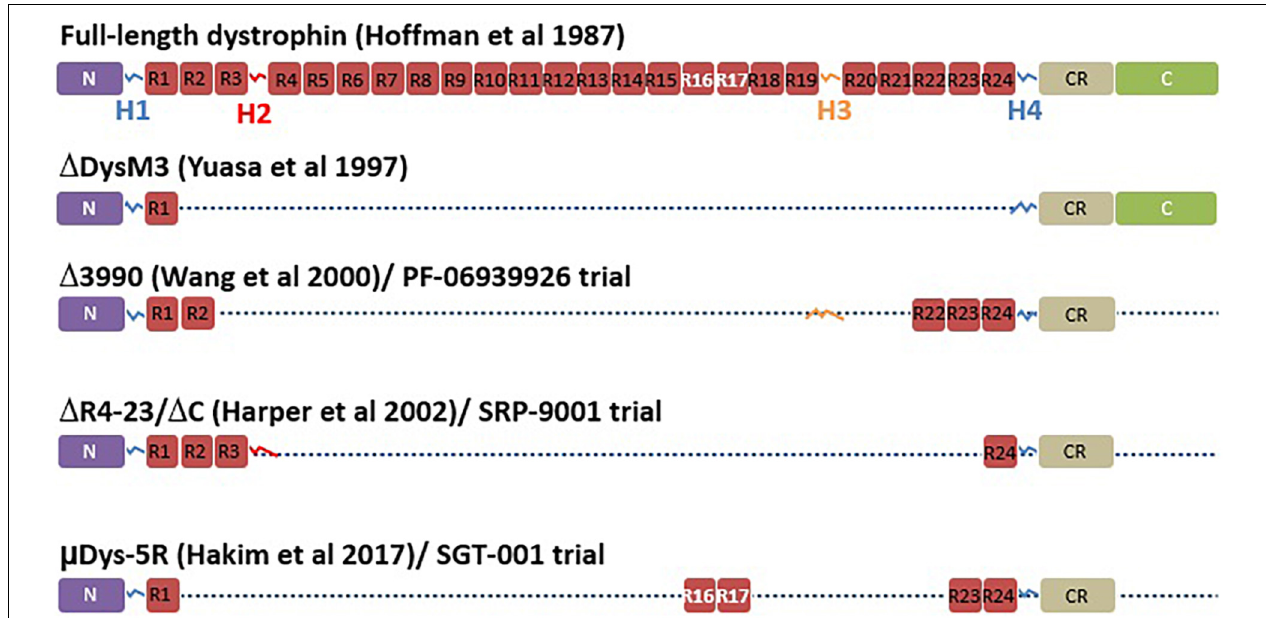
FIGURE 4 | Micro-dystrophin variants. This figure adapted from Duan et al. (147) represents the full-length dystrophin with different domains including the N-terminal domain (N), the four hinges (H), the central rod domain (R), the cysteine rich domain (CR), and the C-terminal domain (C). The figure also illustrates the different versions of micro-dystrophin with lacking domains in use in different clinical trials including the initial micro-dystrophin constructed by Yuasa et al. (149), the (cid:49) 3990 used for the development of PF-06939926, the ( (cid:49) DysM3), the (cid:49) R4-23/ (cid:49) C used for the development of SRP-9001, and finally the µ Dys-5R used for the development of